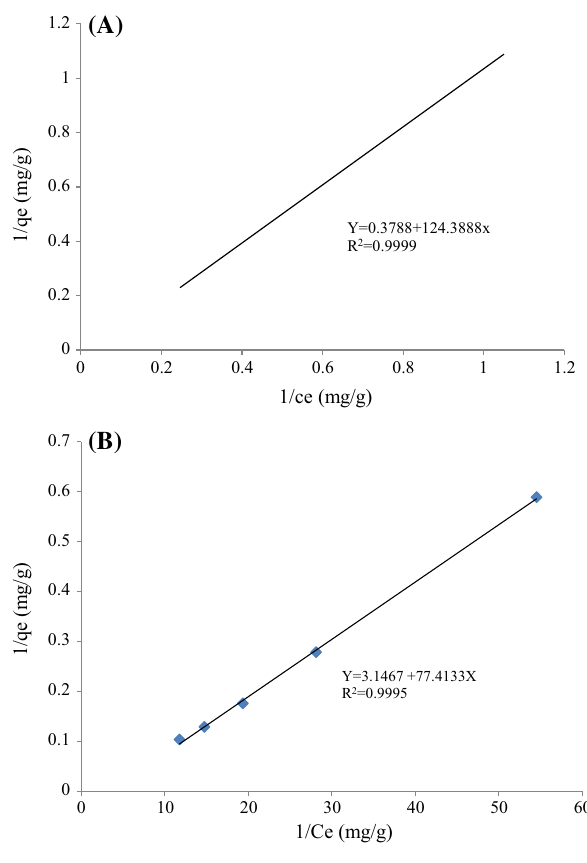
Fig. 4 Langmuir isotherms for the removal of fluoride using a acti- vated mica (MAA) and b mica impregnated with iron